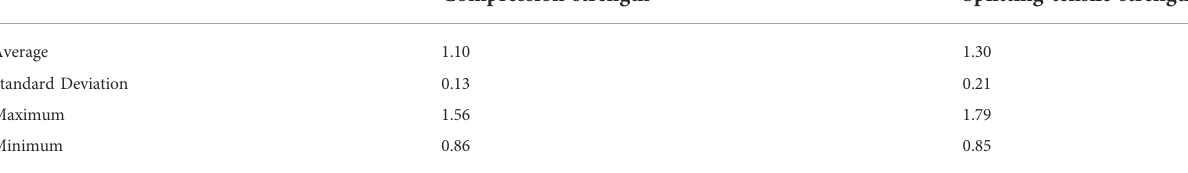
TABLE 4 | Statistical measures for compression and splitting tensile strength.